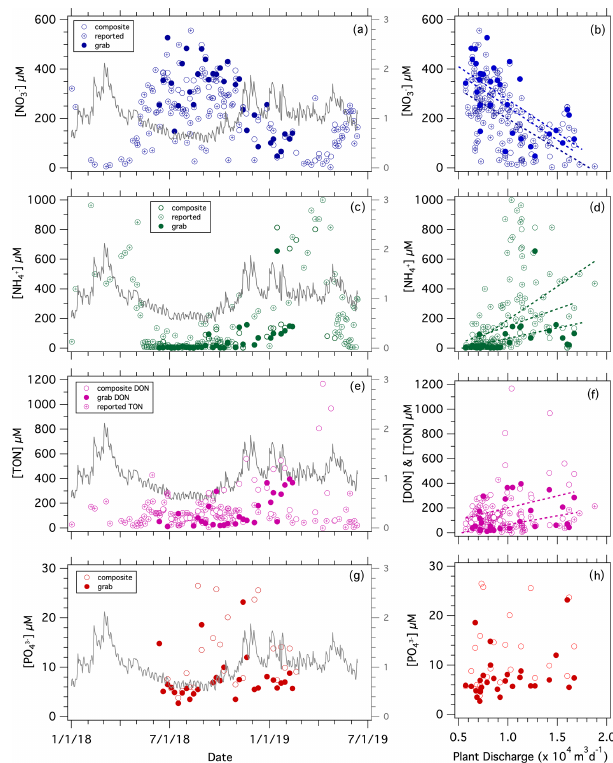
Figure 5. Nutrient discharged from the Westerly WWTF: [NO − ] 3 vs. (a) date and (b) facility discharge; [NH + ] vs. (c) date and (d) fa- 4 cility discharge; [DON] and facility-reported [TON] vs. (e) date and (f) facility discharge; [PO 3 − ] vs. (g) date and (h) facility dis- 4 charge. The grey line corresponds to the WWTF mean daily water discharge with reference to the secondary axis in the left-hand pan- els ( × 10 4 m 3 d − 1 ). Statistical fits of least-square linear regressions are reported in Table